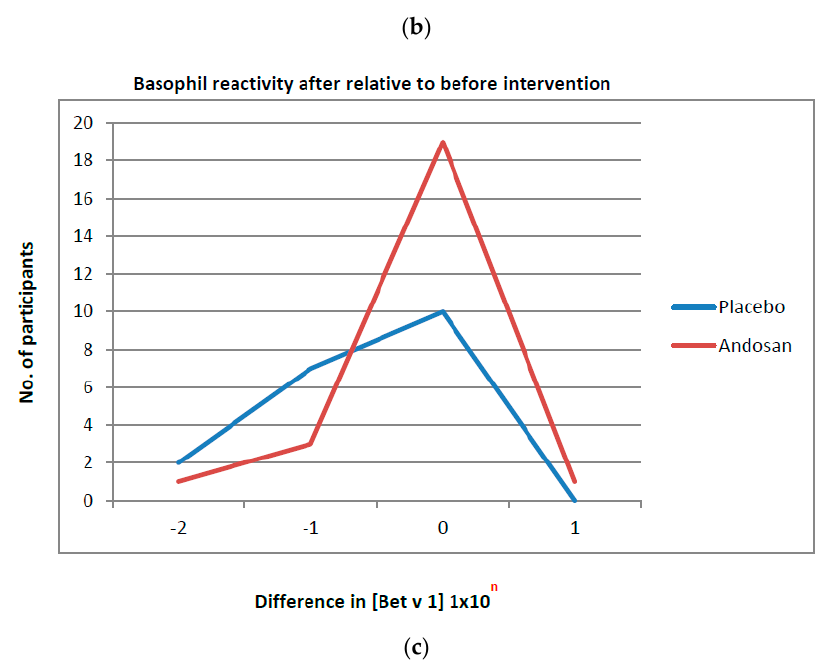
Figure 2. Basophil reactivity in the intervention groups. Basophil reactivity is shown before and after Placebo ( a ) or Andosan TM ( b ) intervention, and after relative to before the respective interventions ( c ). Also see Table 4 for depicted data in ( a, b), and Table 5 for ( c ).